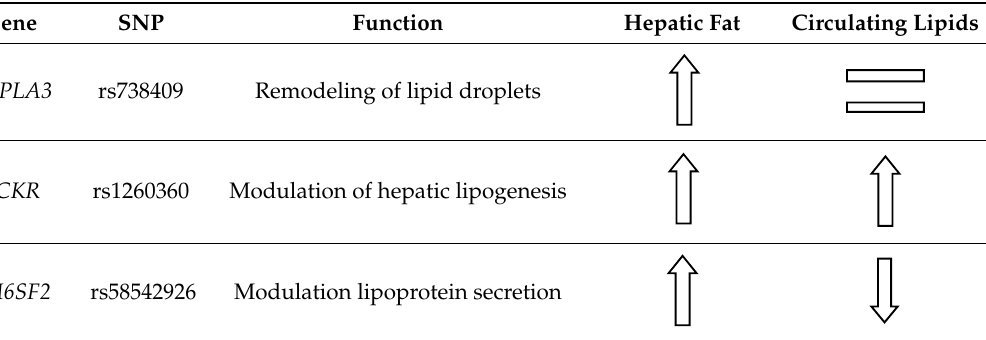
Table 1. SNPs reproducibly associated with pediatric fatty liver. Gene SNP Function Hepatic Fat